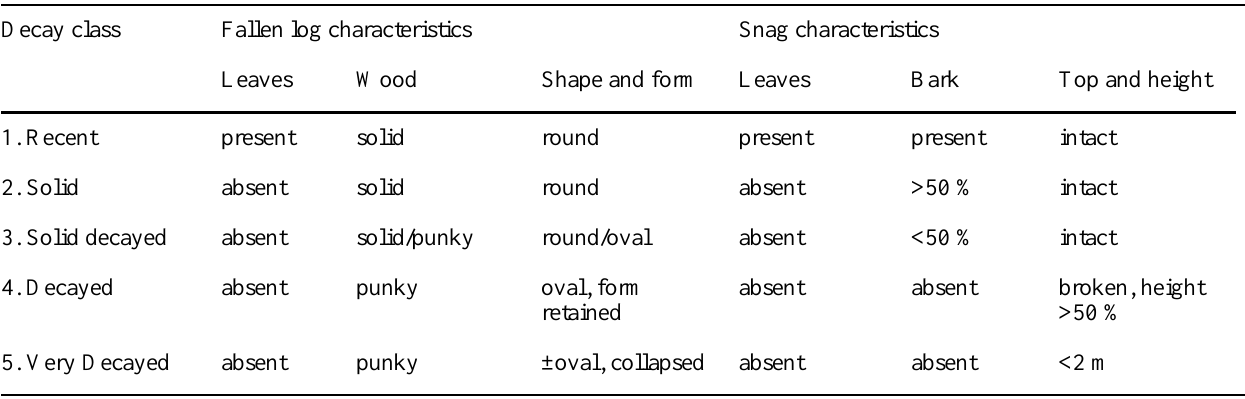
Table 1. Decay classes (1–5) for fallen logs and snags (modified from Tyrrell and Crow 1994; Bergeron et al.